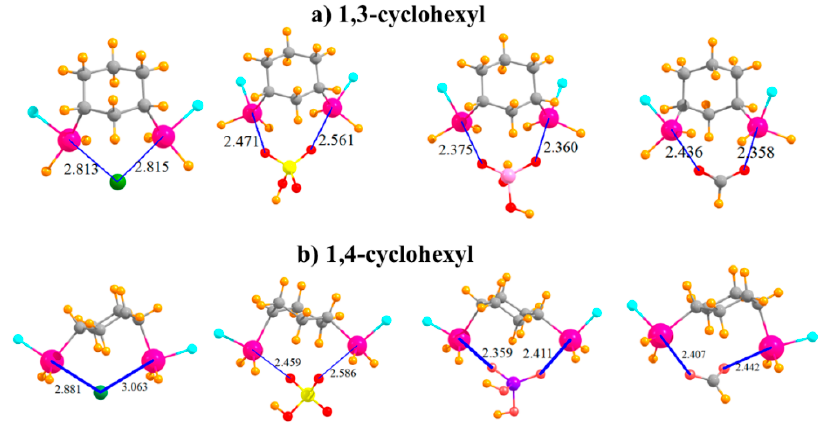
Figure 4. Complexes of Cl − , HSO 4 − , H 2 PO 4 − , and HCOO − with ( a ) 1,3 and ( b ) 1,4 disubstituted cyclohexyl rings.